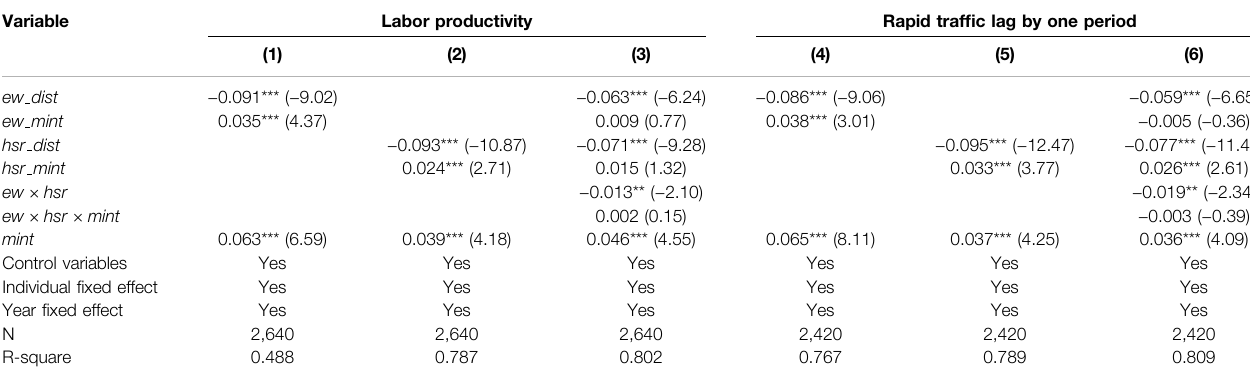
TABLE 4 | Results of robustness tests 1